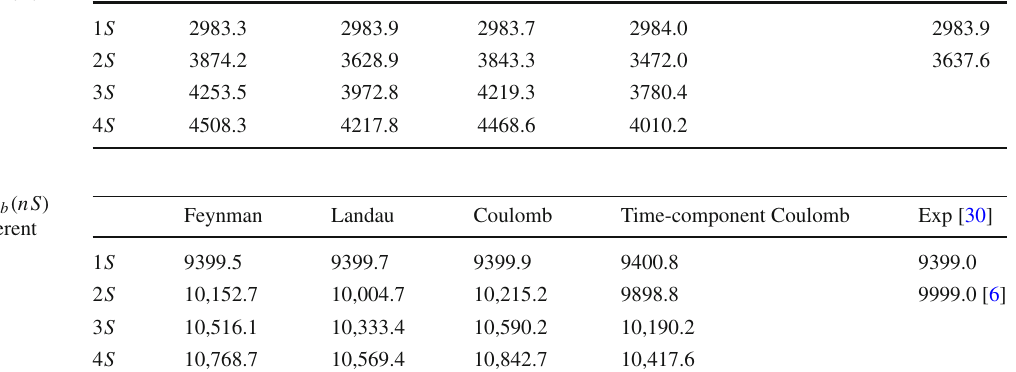
Table 6 Mass spectra of η c ( nS )